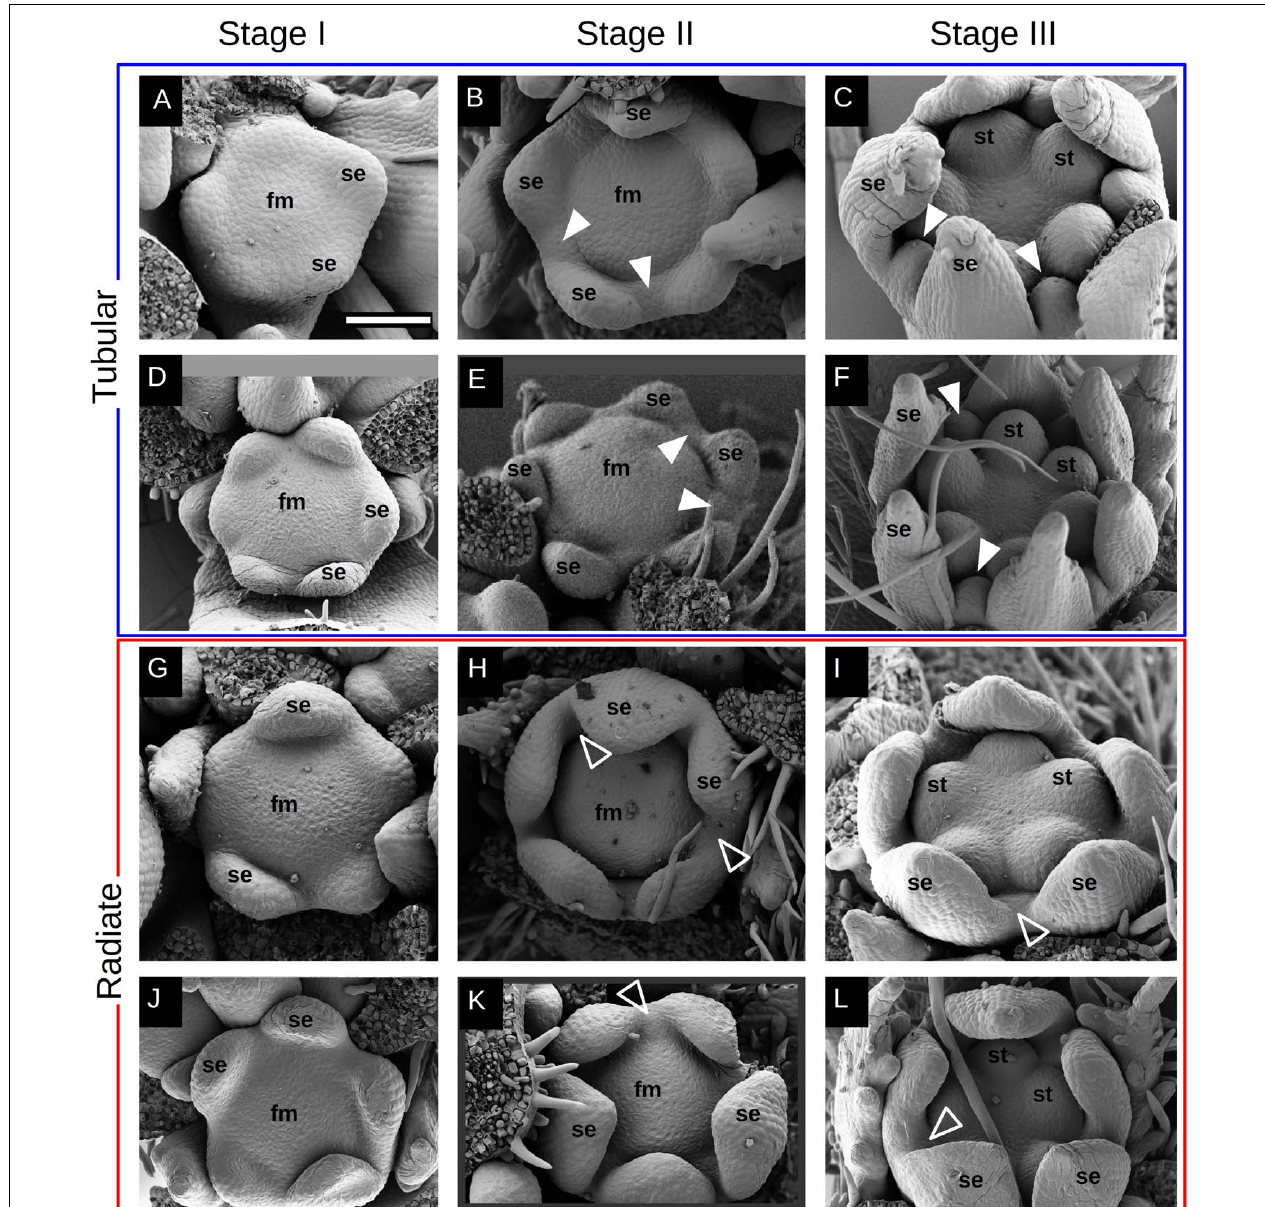
FIGURE 3 | Early development of Malesherbia flower. Images in a same row belong to the same species: Tubular group (blue frame): (A–C) M. tocopillana ; and (D–F) M. auristipulata ; Radiate group (red frame): (G–I) M. lanceolat a; (J–L) M. lirana. Images in the same column correspond to a common developmental stage: (A,D,G,J) stage I: sepal inception; (B,E,H,K) stage II: hypanthium groove initiation; (C,F,I,L) stage III: stamen initiation. (A) Sepal primordia (se) arising around a young flower meristem (fm) of Tubular M. tocopillana. (B) Same species showing a clear hypanthial rim and emergence of petal primordia between sepal lobes (white arrowheads). (C) M. tocopillana showing five round stamen primordia (st), well defined sepal lobes and in between already developing petal primordia (arrowheads). (D) Tubular M. auristipulata flower initiating sepal primordia. (E) Slightly older flower showing petal initiation (arrowheads) between sepal primordia (se). (F) Petal primordia expanding (arrowheads) in between sepal primordia and surrounding the emerging stamen primordia in the center. (G) Radiate M. lanceolata showing sepal (se) inception and a bare flower meristem (fm) in the center. Note the slightly larger size of the young flower in comparison to the Tubular species shown in panels (A) and (D) . (H) A clear hypanthial rim is established in the young flower while sepal lobes expand toward the center. At this point, no petal primordium can be seen in the space between sepal primordia (open arrowheads) in contrast with the Tubular species shown in panels (B) and (E) . (I) Same species with marked stamen primordia in the center still lacking petal primordia between sepal lobes (open arrowhead). (J) Radiate M. lirana developing flower with a bare flower meristem in the center (fm) and emerging sepal lobes (se). (K) Flower primordium showing hypanthial rim and a sustained growth of sepal lobes. Note the larger sized sepal lobes at this point in Radiate species (H,K) , compared to Tubular species (B,E) . (L) Stamen primordia clearly shown in the flower center while petal primordia are still lacking (open arrowhead). Bar in panel (A) for all Figures = 100 µ m. fm = flower meristem, se = sepal, st = stamen. White arrowhead = petal primordium, open arrowhead = petal primordium still not